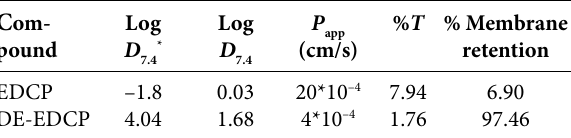
Table 4: Lipophilicity and passive membrane permeability data for the investigated substances DE-EDCP and EDCP C om-